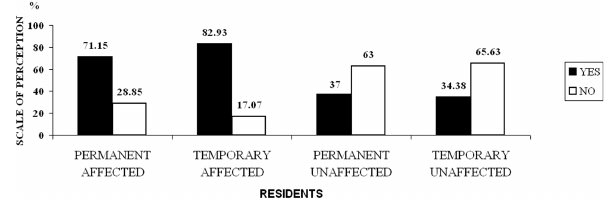
Fig. 3. Perception of vulnerability to flooding. Residents.